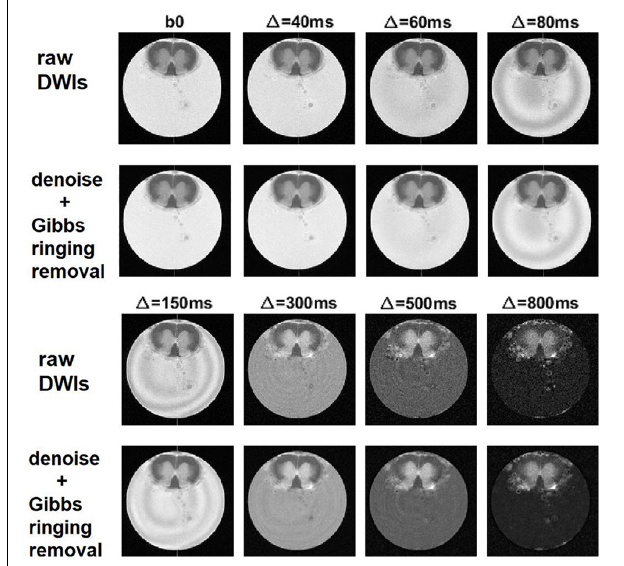
FIGURE 4 | Denoising and removal of Gibbs ringing artifact in DWI used to obtain α -imaging. Comparison between the raw DWIs and the DWIs after denoising and the removal of Gibbs ringing artifact, for the lumbar slice of the spinal cord, considering the DWIs acquired along z-direction and using increasing diffusion time, (cid:49)